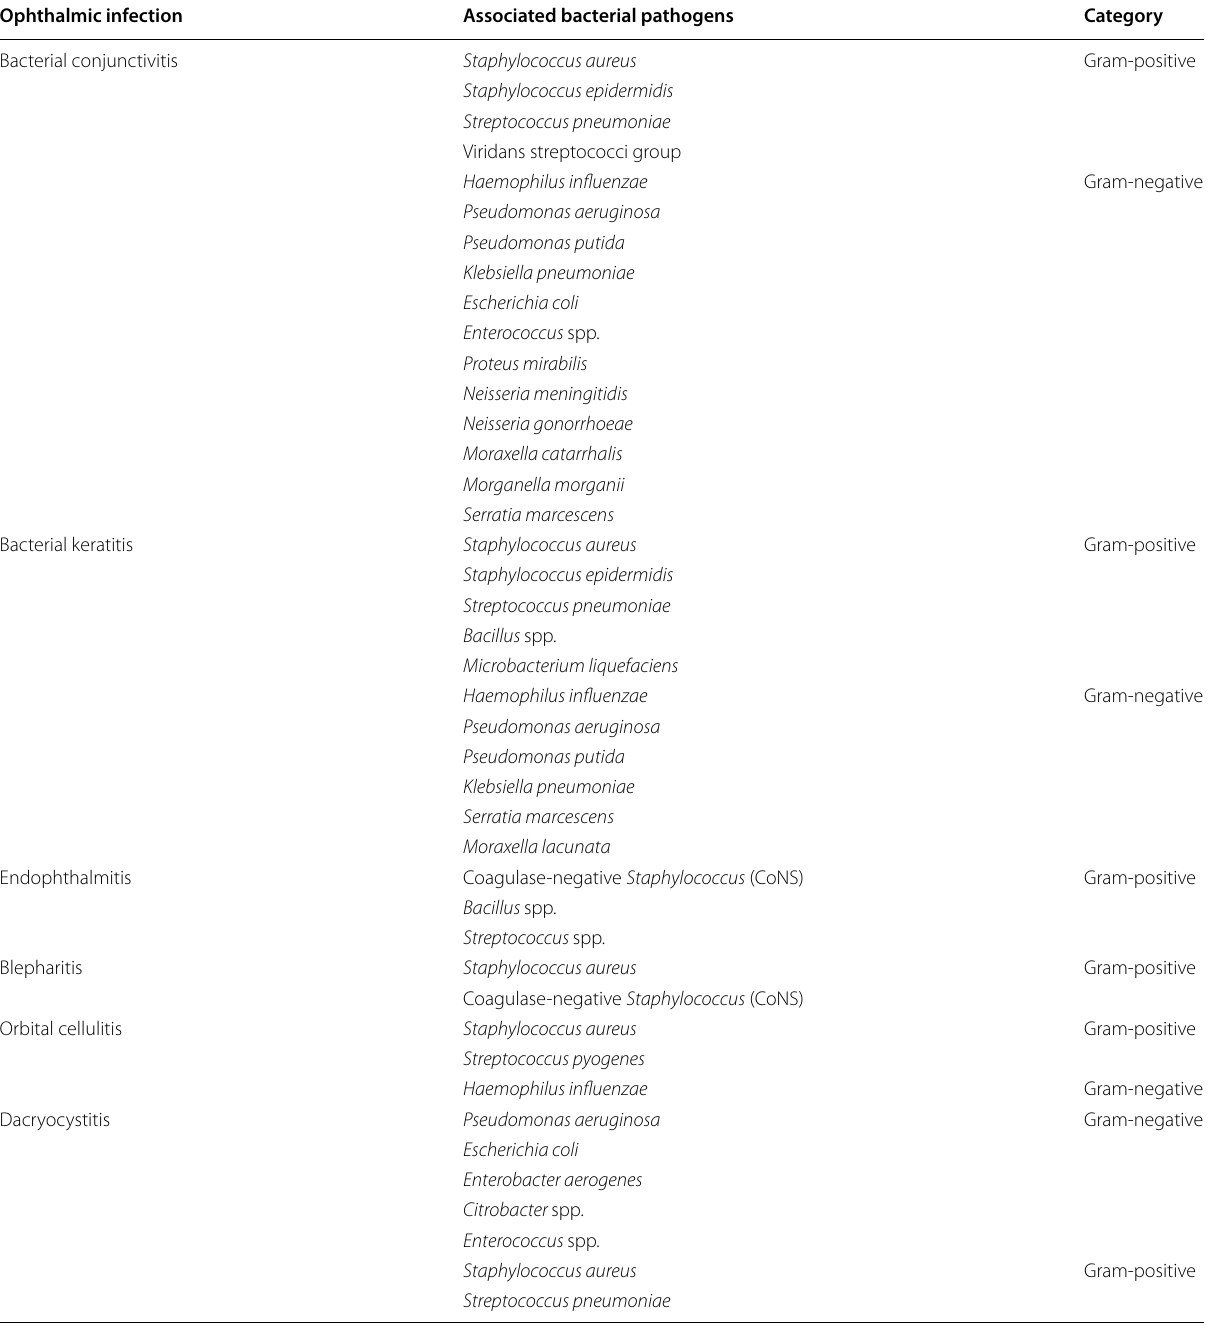
Table 1 Ophthalmic infections and their commonly associated bacterial pathogens Ophthalmic